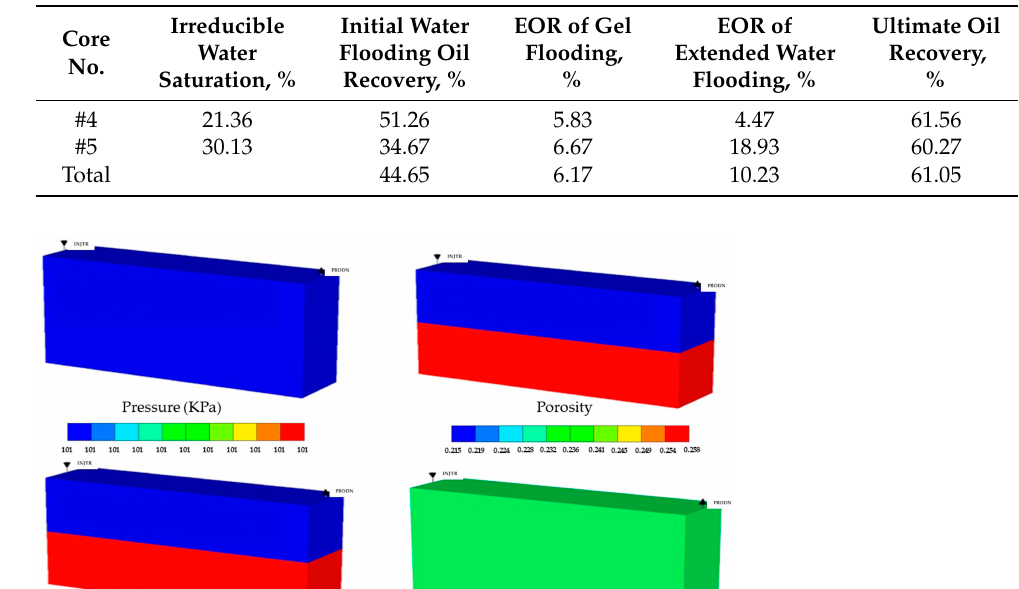
Figure 5. The production index curve of the gel flooding experiment. Table 4. The statistics of the production indexes of the gel flooding experiment.